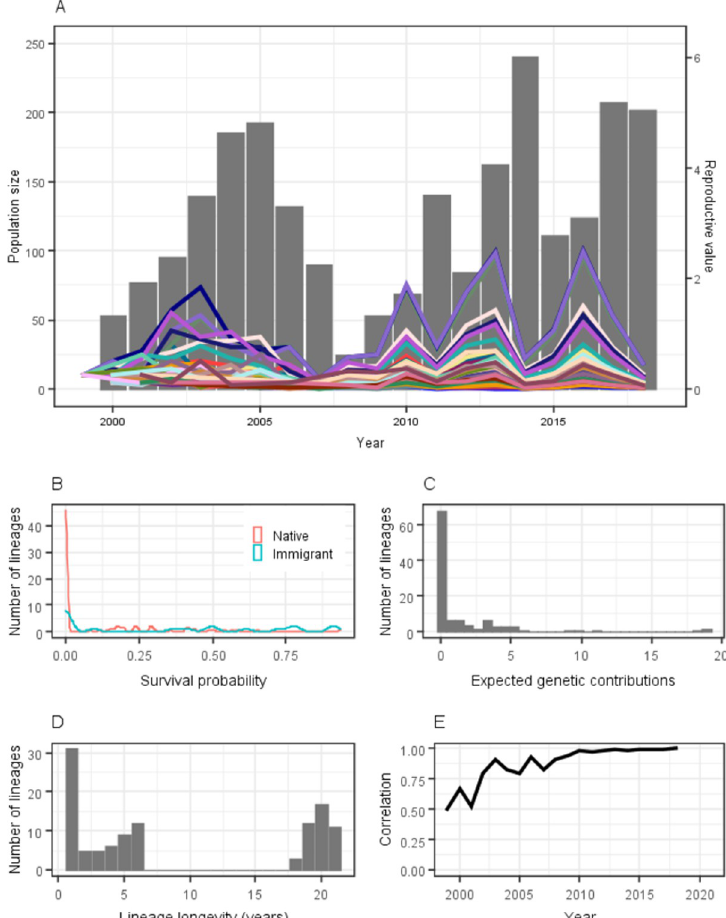
Fig 1. (A) Reproductive values and population size during the study period. Bars represent the population size and lines represent the reproductive values of each of the 43 lineages that survived to 2018. (B) Survival probability of 111 house sparrow lineages on Lundy Island from 1999 to 2018. (C) Reproductive values of the 111 lineages. (D) Number of years to lineage extinction for the 111 lineages. Lineages that survived 18, 19, 20 or 21 years are those that were